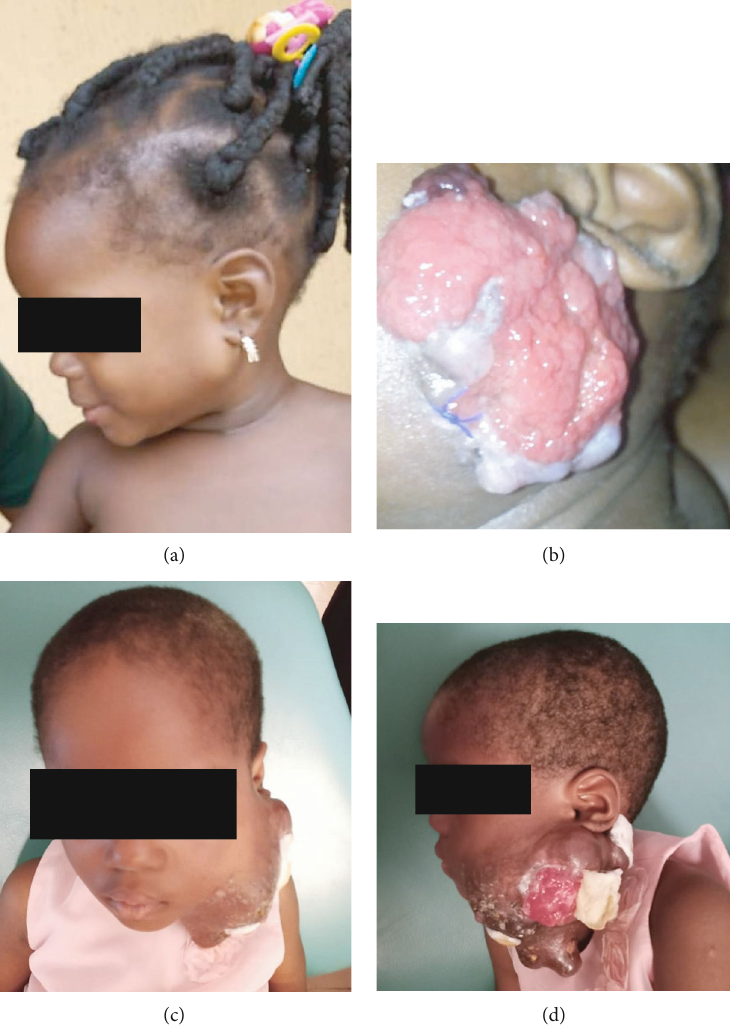
Figure 1: Clinical images of a female child diagnosed with a MAML2 -rearranged mucoepidermoid carcinoma of the parotid gland. Painless parotid mass in a 1-yr 8 months old female patient (a). Few weeks after an initial incisional biopsy, an ulcerated rapidly increasing mass extending to the check area and lifting the ear (b). 2 years later, multiple ulceration sites on the 12cm parotid mass (c,